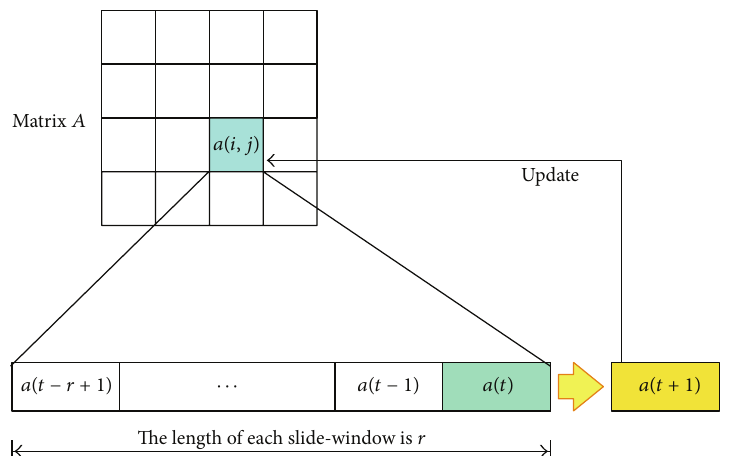
Figure 3: Matrix 𝐴 and the slide-window.